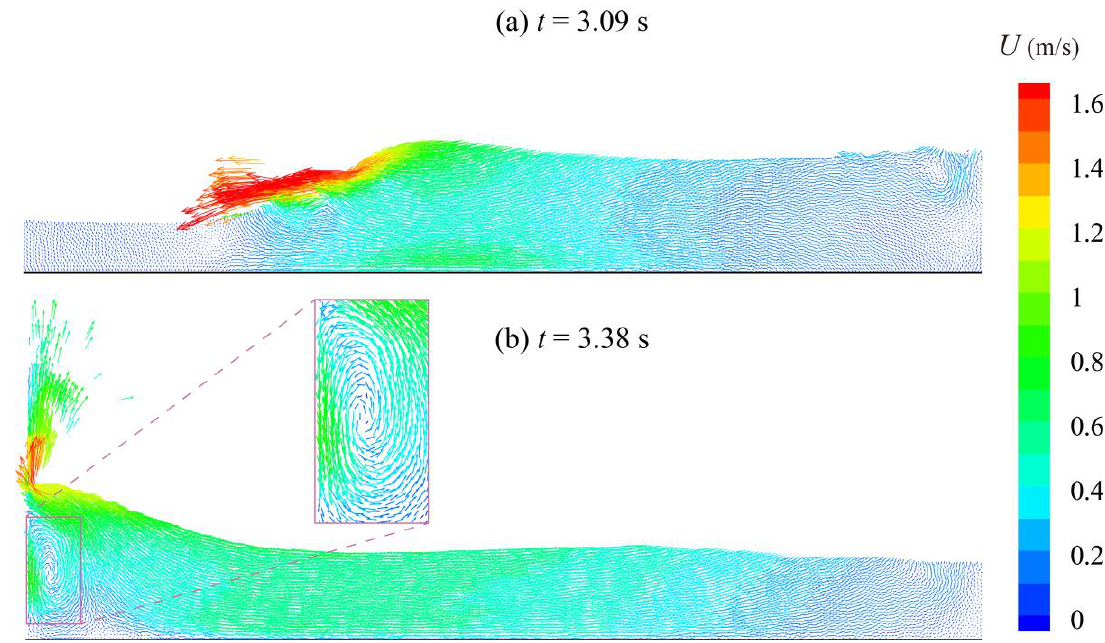
Figure 4. Velocity fields during liquid sloshing without a baffle. ( a ) t = 3.09 s; ( b ) t = 3.38 s.